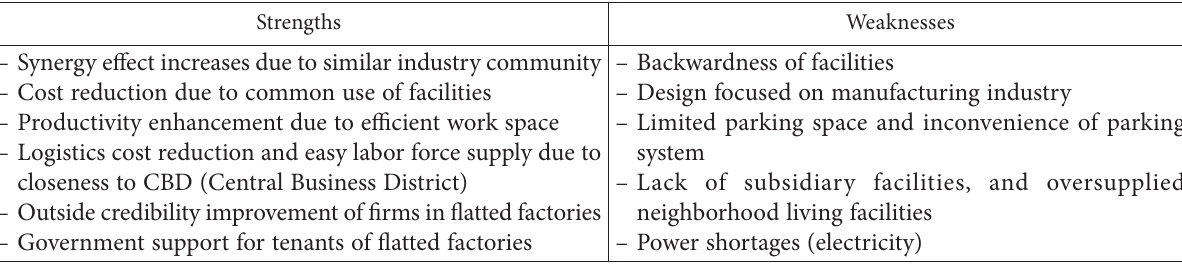
Table 1. Strengths and weaknesses of a flatted factory (source: Industrial Land Information System: http://www.industryland.or.kr)